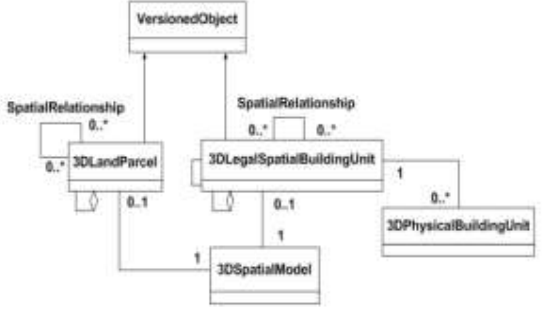
Figure 3. Prototype system based on the LADM standards